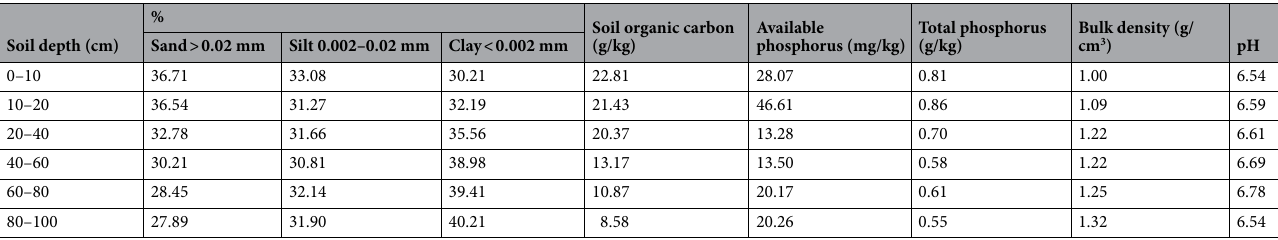
Table 1. Physical and chemical properties of the initial soils sampled in